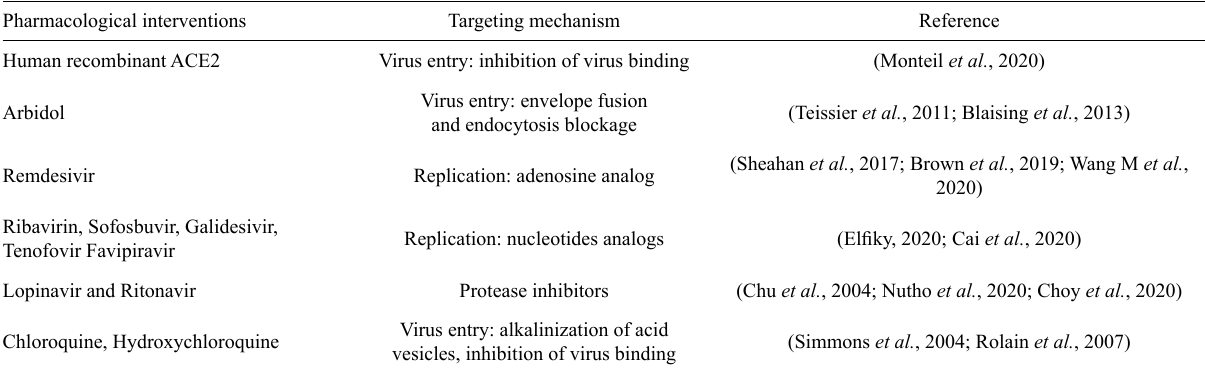
Table 4 – Pharmacological interventions targeting the replication cycle of human coronaviruses. Pharmacological